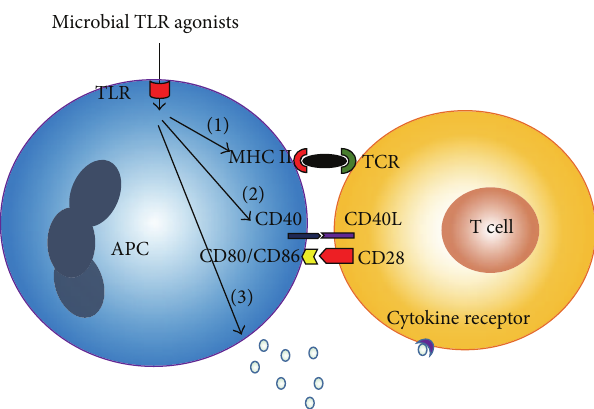
Figure 2: Toll-like receptor (TLR) activation on antigen presenting cells (APCs) enhances the antigenic signal to T cells. TLR activation induces the upregulation of MHC II (1), costimulatory molecules such as CD80, CD86, and CD40 (2), and release of cytokines (3).